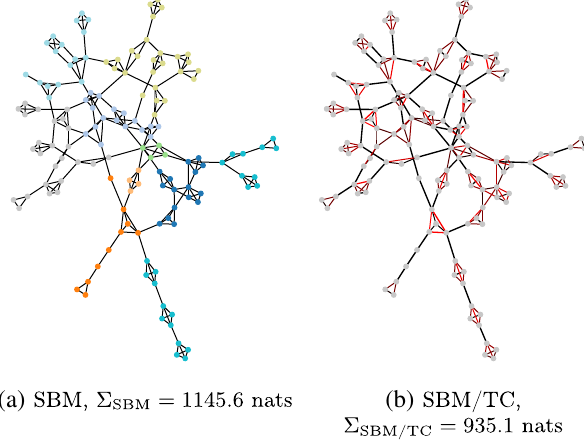
FIG. 5. Network of cooperation between students [48]. (a) Fit of the SBM, yielding B ¼ 9 communities. (b) Fit of the SBM/TC, uncovering a single community, and triadic closure edges shown in red. The thickness of the edges corresponds to the marginal probabilities π and 1 − π for the seminal and closure edges, ij ij FIG. 4. Recovery of community structure for artificial networks generated from the PP model with added triadic closure, as described in the text, for networks with N ¼ 10 4 nodes, average degree h k i ¼ 5 , B ¼ 10 planted groups, and uniform triadic p , shown in the legend. Panels (a) and closure probability p u ¼ (b) correspond to inferences done using the SBM, and (c) and (d) correspond to those with the SBM/TC model. All results were averaged over ten network realizations. The vertical dashed line marks the detectability transition value c (cid:3) described in the text. þ